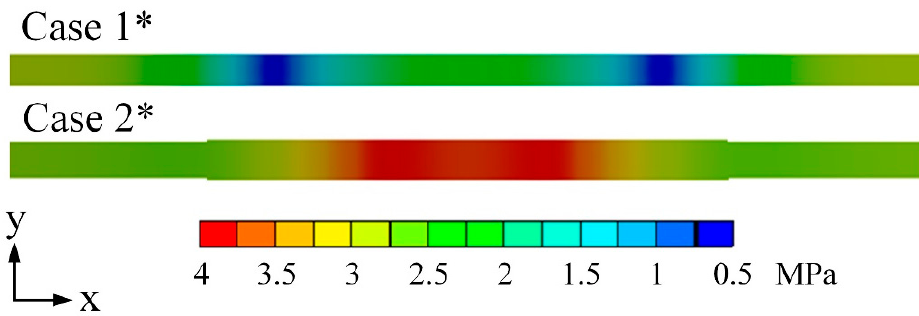
Figure 6. Distribution of oxygen mass fraction in the cathode channel cross sectional plane near the cathode inlet (z = 5 mm) when the operating voltage is 0.6 V in the Base case*, Case 1* and Case 2*.